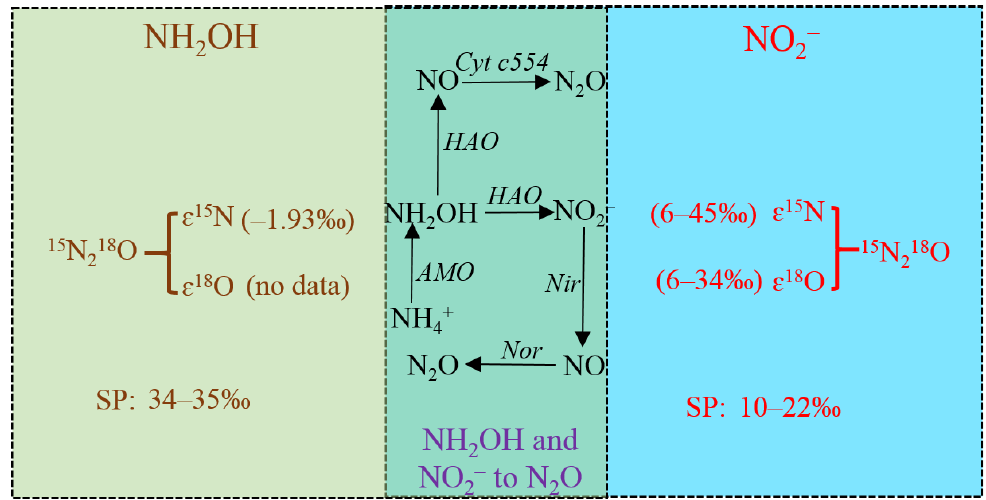
Figure 2. Isotopic fractionation of N and O during the N 2 O production from abiotic processes of NH 2 OH and NO 2 −